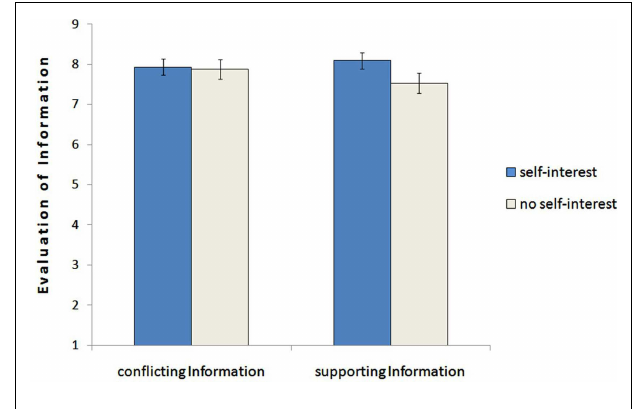
FIGURE 2 | Mean differences representing the evaluation of information regarding supportive and conflicting information for advisors with self-interest and without self-interest. The error bars represent SEM (study 1).